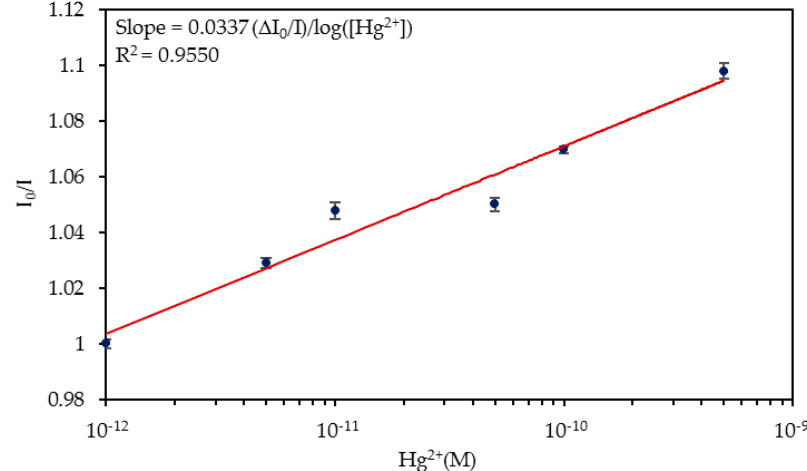
Figure 8. I 0 /I ratio for the different Hg 2+ concentrations in ultrapure water. The horizontal axis is shown in logarithmic scale.